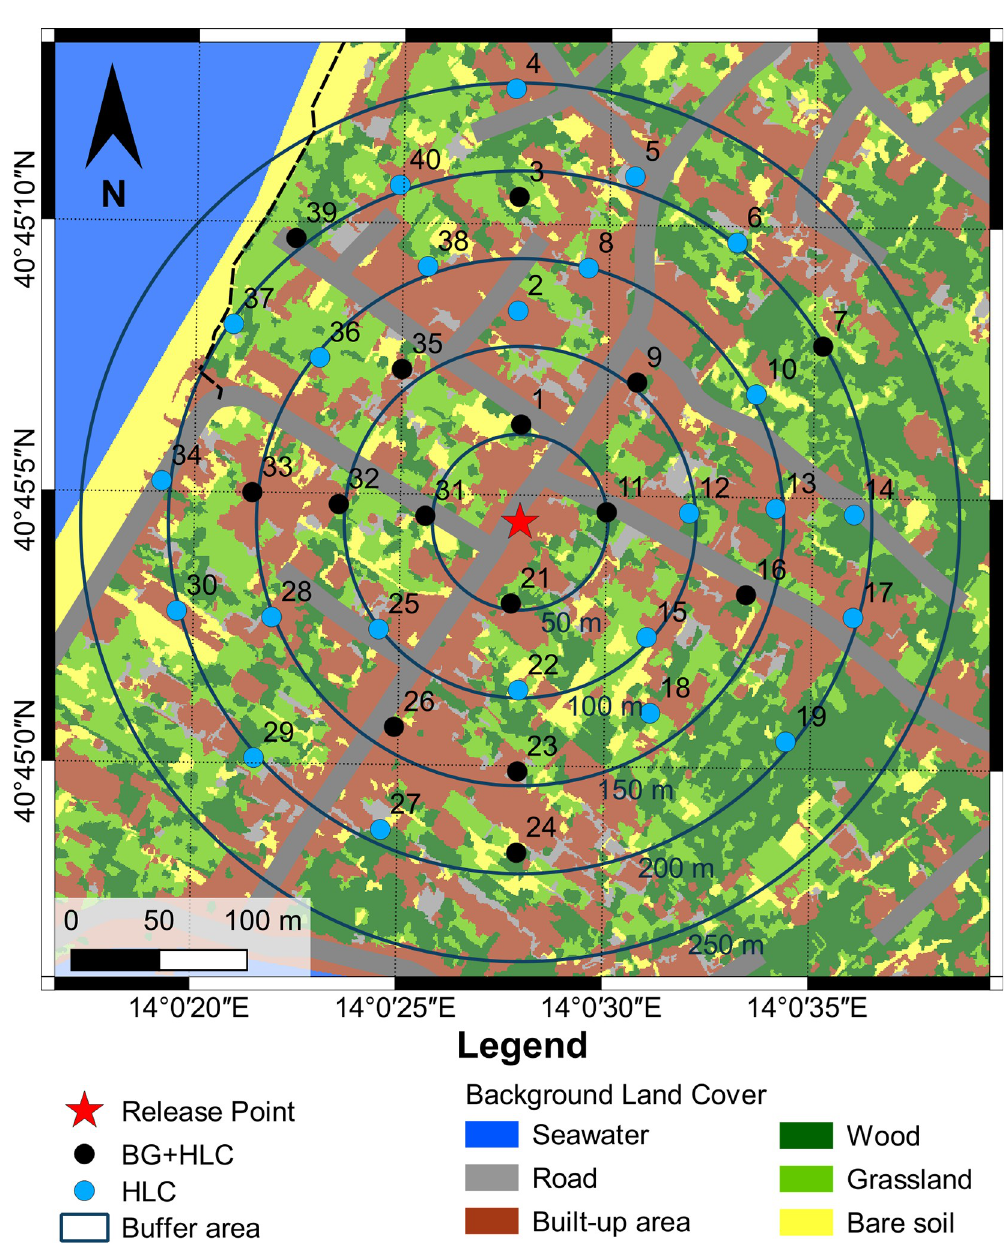
Fig 5. Distribution of Aedes albopictus sampling stations in the mark-release-recapture study site in “La Chiaiolella” (Procida). Red star = release site. Black circles = HLC + BG-traps recapture stations. Light blue circles = HLC recapture stations. Circles = 50 m-annuli around release site. The base layer of the geographic background map has been sourced from an open maps access (https://glovis.usgs.gov/app).